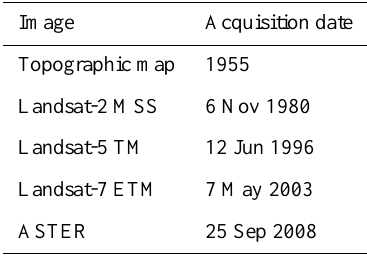
Table 1. Data source for monitoring glaciated